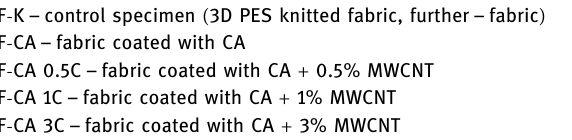
Table 1: Description of samples CA ( only capric acid )